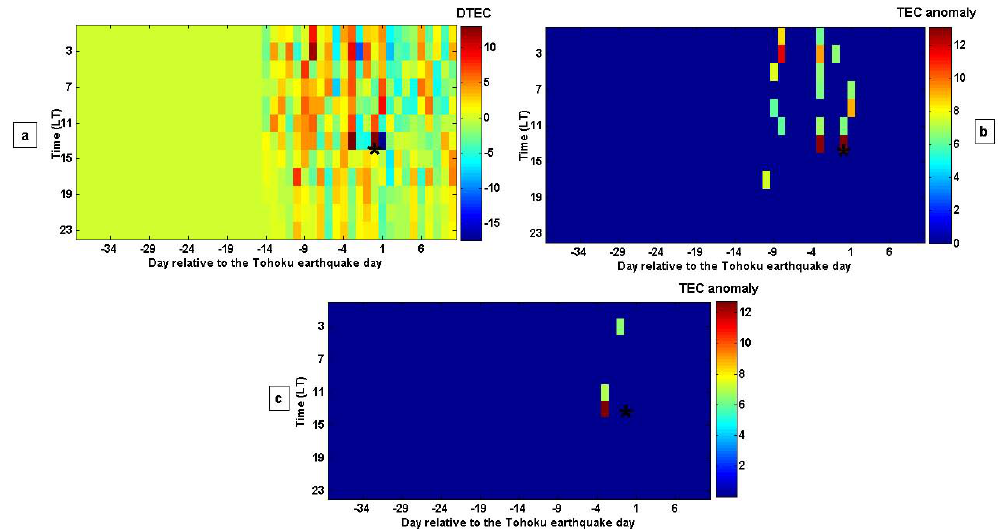
Fig. 6. Results of analysis for the Tohoku earthquake using the Kalman filter method, (a) the differences between observed and predicted TEC values, (b) detected TEC anomalies without considering the geomagnetic conditions, and (c) detected TEC anomalies during quiet geomagnetic conditions. Table 2. Detected anomalies in quiet geomagnetic conditions for the Tohoku earthquake using the mean, median, wavelet and Kalman filter methods. Day shows the number of days before the earthquake. Value is calculated by p = ± 100 × ( | Dx |− k) /k . Mean Median Wavelet Wavelet Kalman filter (Approximation)